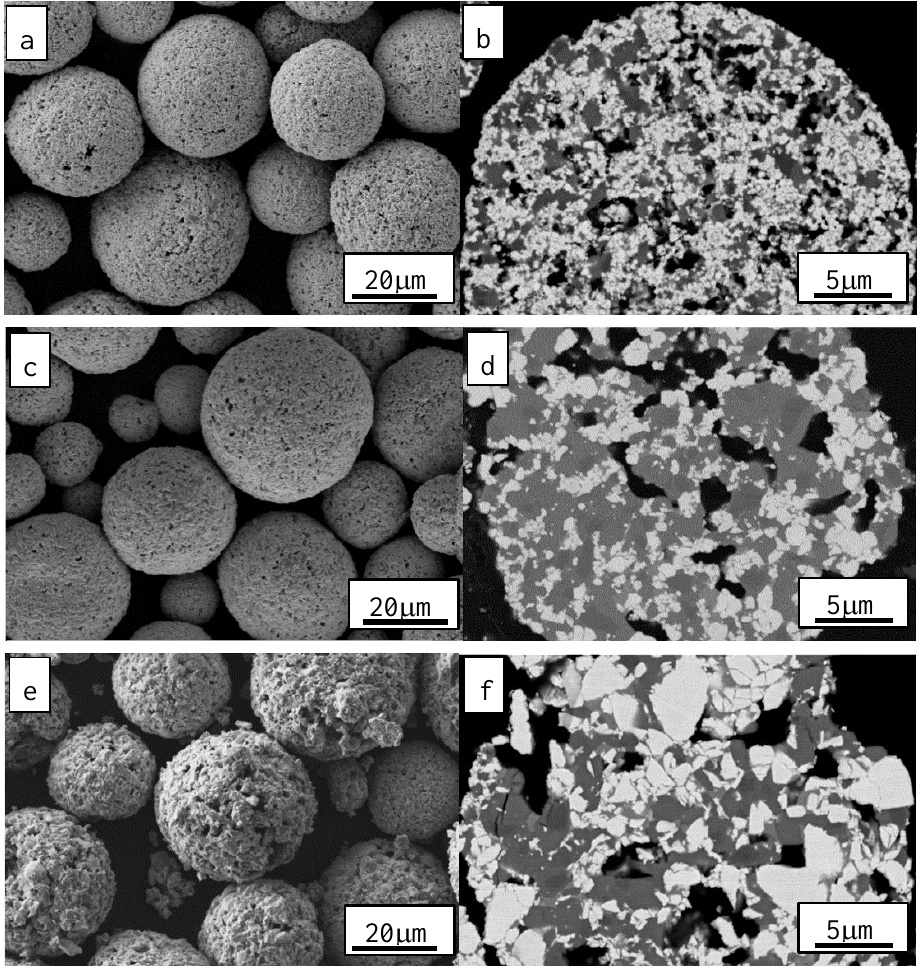
Figure 1. Surface morphologies of the ( a , b ) FP; ( c , d ) MP and ( e , f ) CP powders.